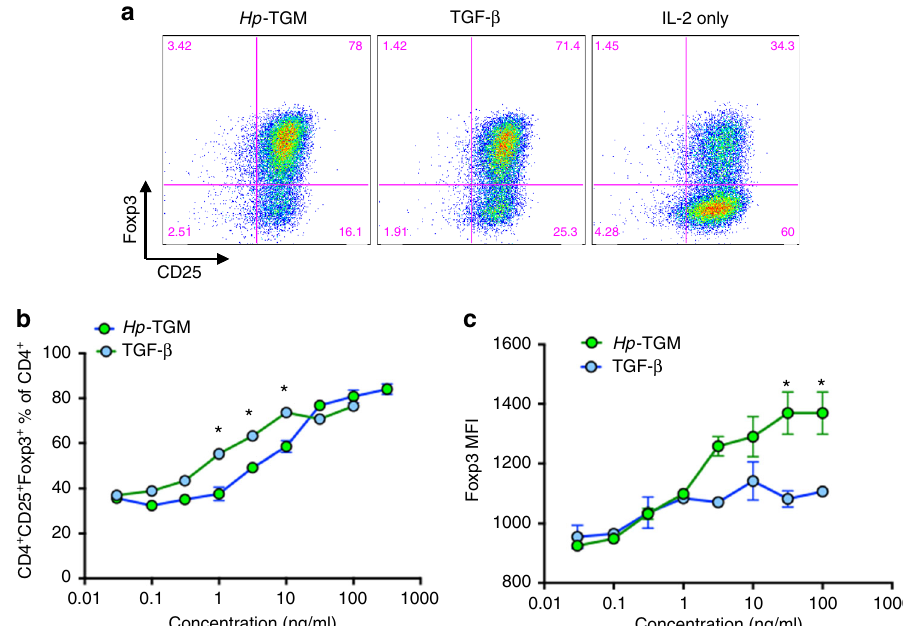
Fig. 5 Hp -TGM induces Foxp3 expression in human T cells. a – c Human peripheral blood mononuclear cells were separated from red blood cells over a Ficoll gradient and CD4 + T cells isolated by MACS positive selection. Isolated cells were cultured at 37 °C for 96 h with a 1:1 ratio of CD3/CD28 Dynabeads® and variable concentrations of hTGF- β 1 or Hp- TGM. Induction of Tregs from human peripheral blood monuclear cells. Data are means and SEM from two technical replicates per concentration and representative of 2 independent experiments, analysed by unpaired t test and corrected for multiple comparisons; * p < 0.05. Gating strategy is shown in Supplementary Fig. 6. a Representative fl ow cytometry plots (CD4 + population shown) of MACS-puri fi ed CD4 + positive selected PBMCs stimulated with Hp -TGM, hTGF- β or IL-2 respectively; b Percentage of CD25 + Foxp3 + cells among total CD4 + cells; c MFI of Foxp3 among Foxp3 +